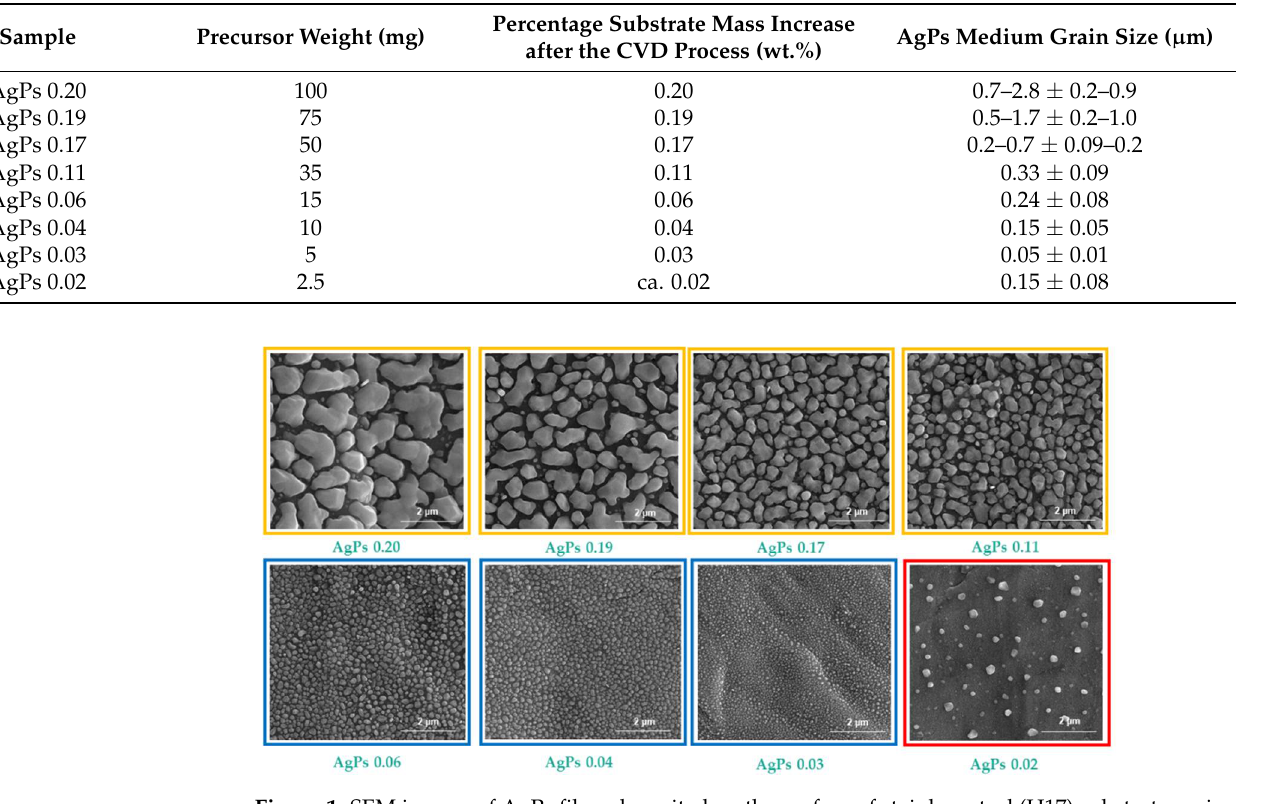
Figure 1. SEM images of AgPs films deposited on the surface of stainless steel (H17) substrates using CVD technique. Table 2. AgNPs films deposited by CVD technique.